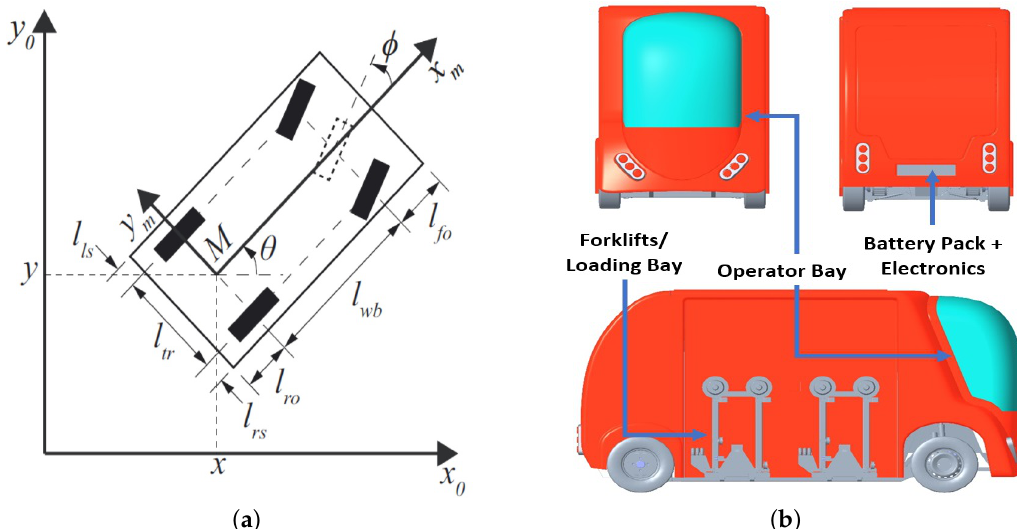
Figure 7. ( a ) Vehicle kinematic model. ( b ) FURBOT